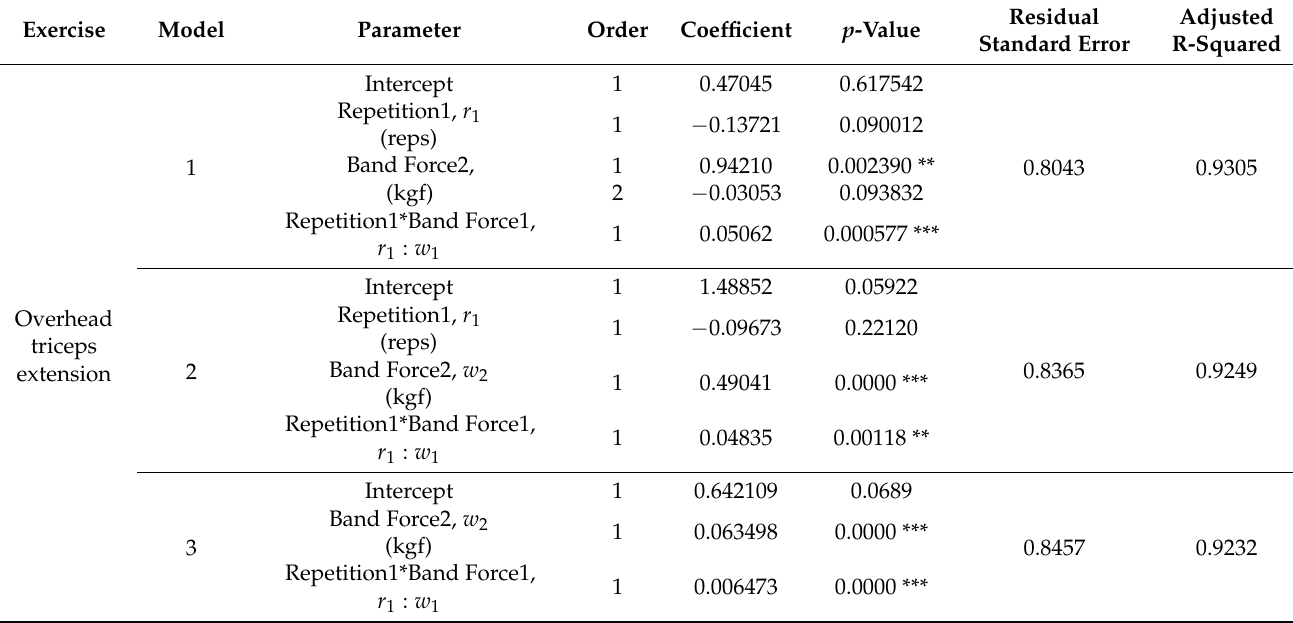
Table A5. Overhead triceps extension 1 − RM equations and model reduction.